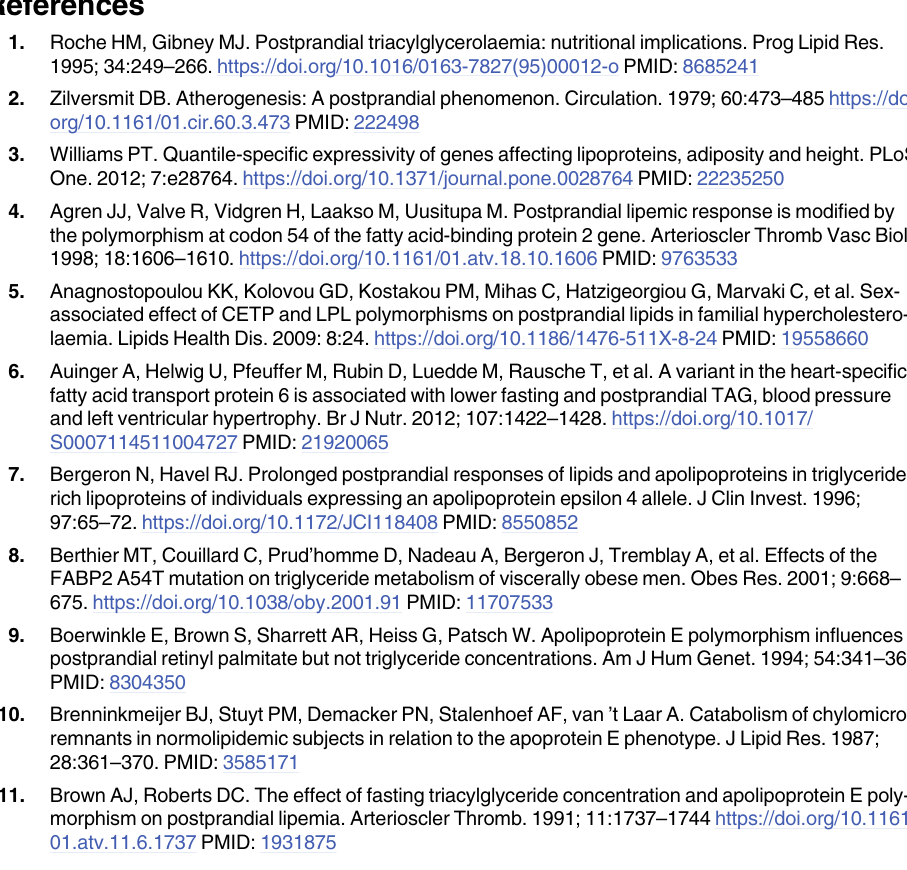
S1 Table. Studies identified as providing graphs of the postprandial triglyceride